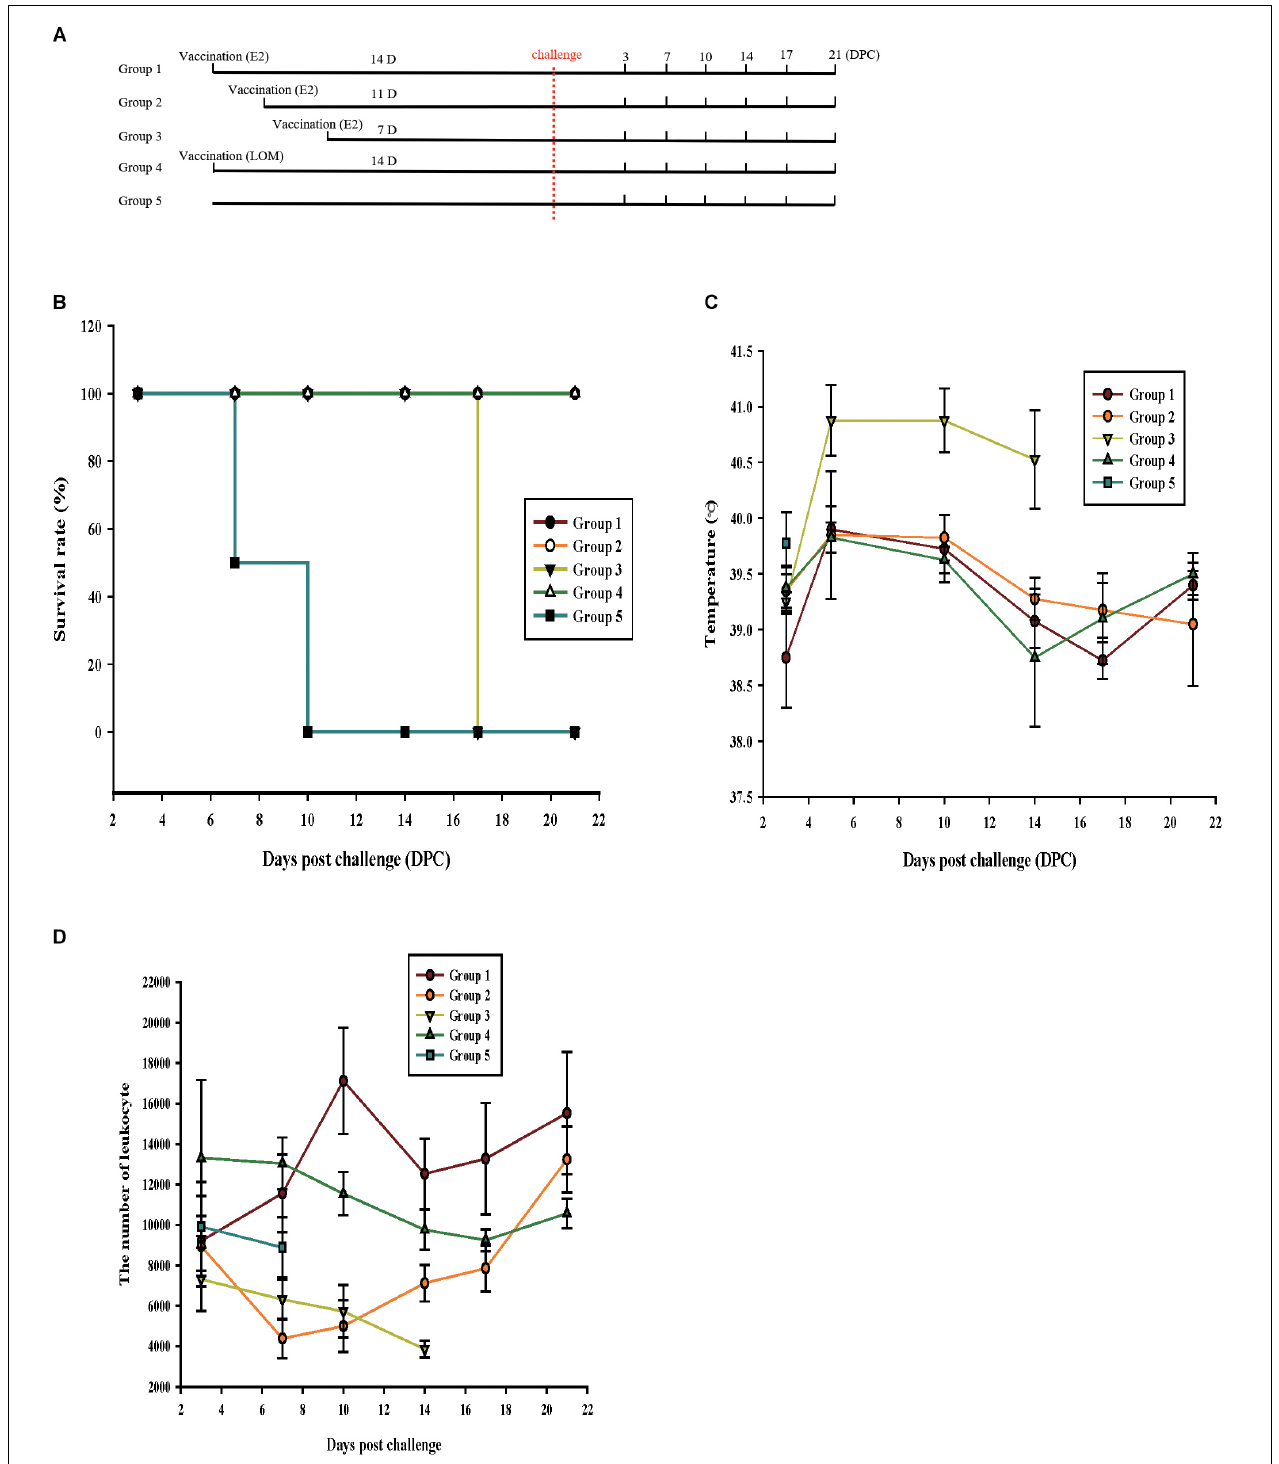
FIGURE 7 | Single-dose vaccination with plant-produced E2 fusion protein can provide effective protection after 11 days. (A) Schedules of single-dose vaccination and challenge with virulent classical swine fever virus (CSFV). Piglets were vaccinated with plant-produced E2 fusion protein (ppE2) or live CSFV vaccine strain LOM. Survival and clinical conditions of vaccinated pigs after viral challenge were monitored at 0, 3, 7, 10, 14, 17, and 21 days post-challenge. (B) Survival of immunized and control (non-immunized) piglets. (C,D) Symptoms of CSFV infection in animals with single-dose vaccination. Body temperatures (C) and the number of WBCs (D) from all piglets were examined at the indicated time points until the animals died or were euthanized. Piglets from group 3 displayed abnormal clinical signs before death, and non-vaccinated pigs all died soon after challenge. Data are mean ± SEM for four piglets per group.